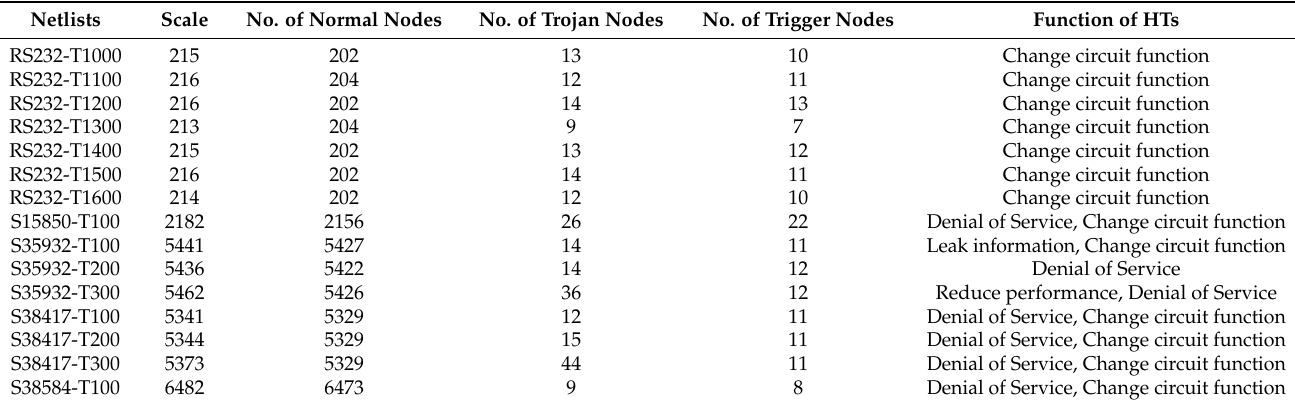
Table 3. Description of HT